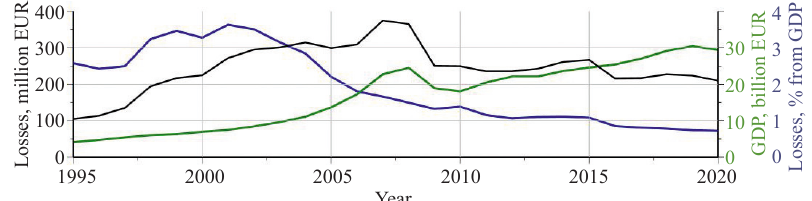
Figure 11. Economic losses from road traffic